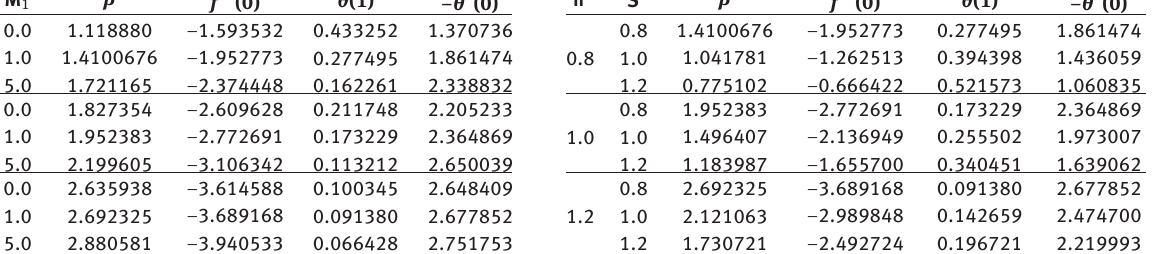
(cid:2) (0) for different values of Pr